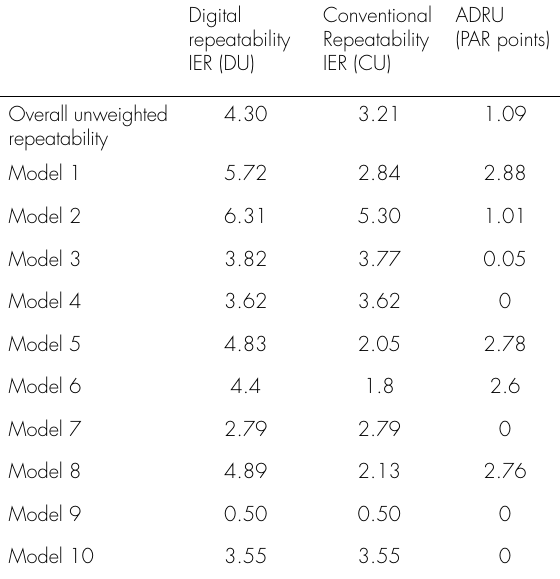
Table II. Carstensen analysis for weighted PAR scores.